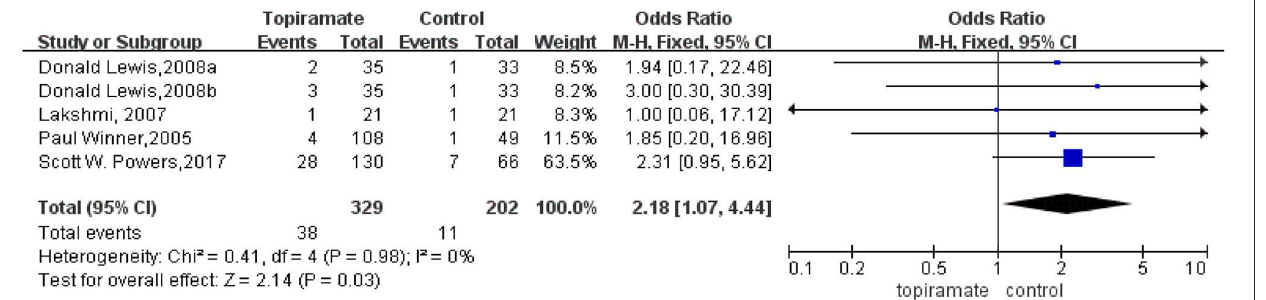
FIGURE 7 | Withdrawals for any reason between topiramate and placebo groups.